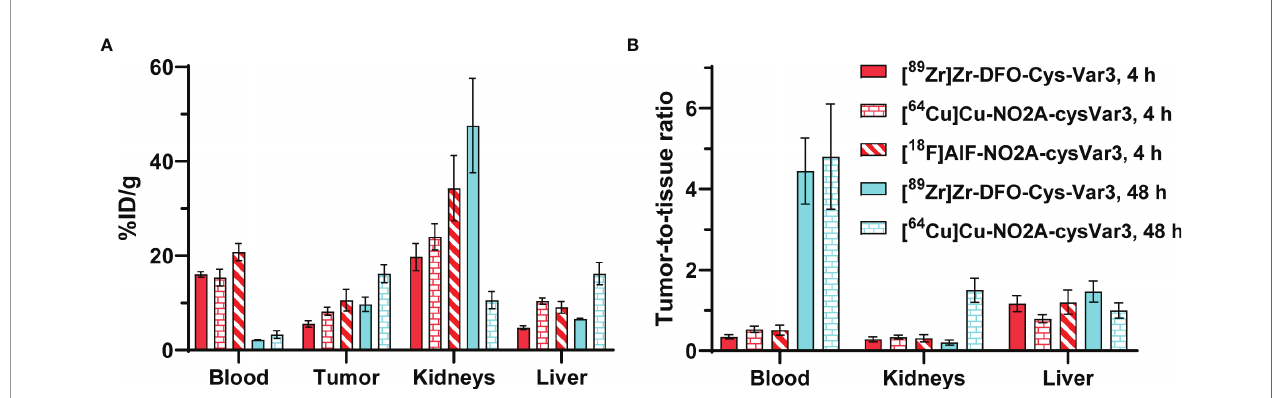
FIGURE 8 | (A) Comparison of the biodistribution in the 4T1 tumor model of [ 89 Zr]Zr-DFO-Cys-Var3 to [ 64 Cu]Cu-NO2A-cysVar3 and [ 18 F]AlF-NO2A-cysVar3 from a previously published study (38). (A) %ID/g of selected tissues at 4 and 48 hours post-injection of the radiotracers. (B) Selected tumor-to-tissue ratios at 4 and 48 hours post-injection of